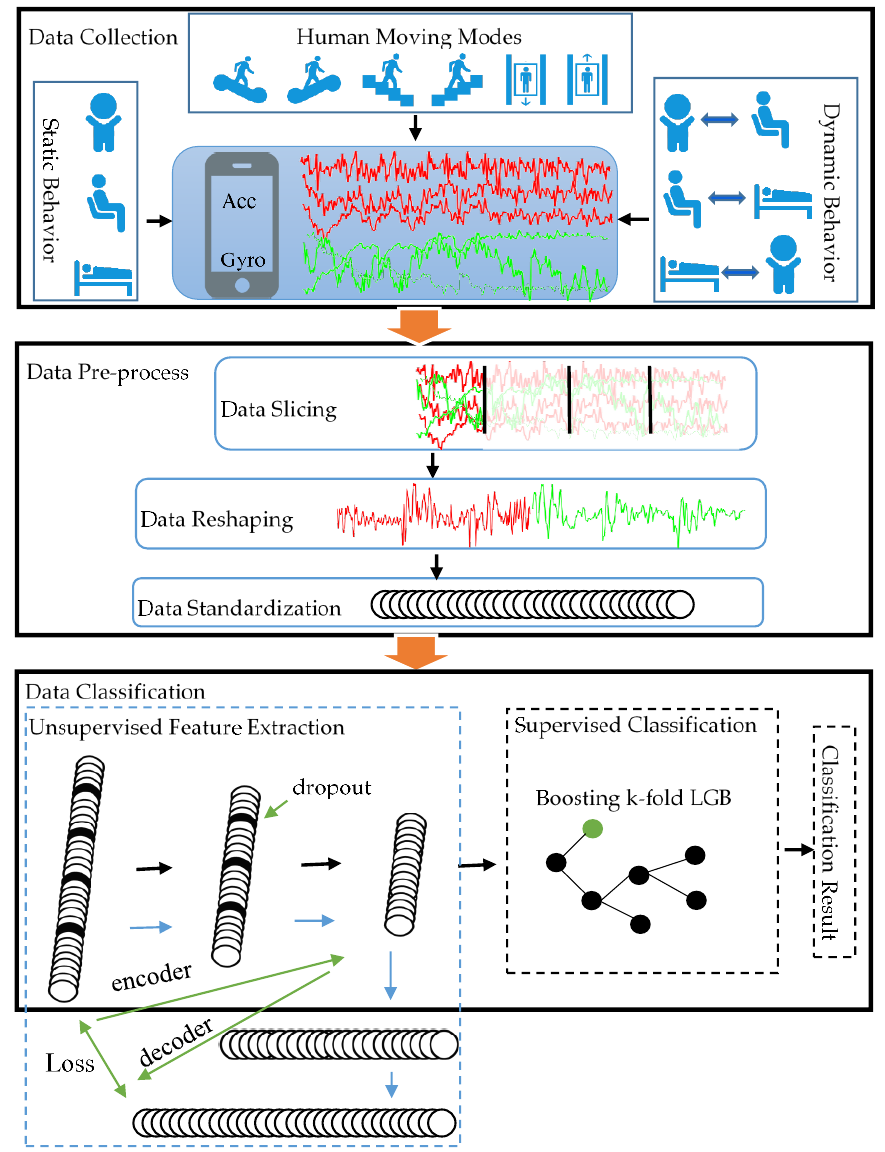
Figure 1. The architecture of the classification network. The solid black line in the data classification module represents the process of data classification while the solid blue line represents the encoding and decoding process of SDAE.